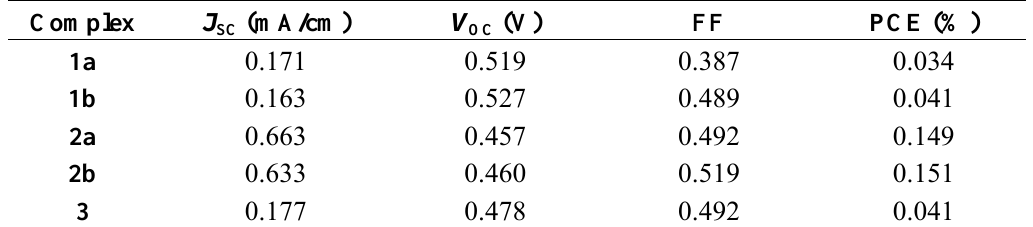
Table 1. Short-circuit current densities ( J and power conversion efficiencies (PCE) for DSSCs with coordination polymers containing dithiocarbamate